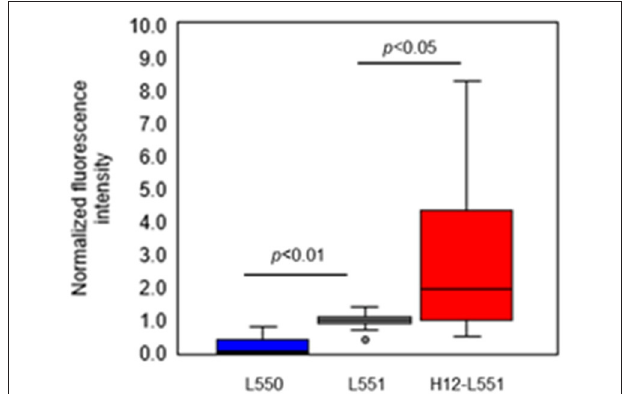
FIGURE 5 | Comparison of normalized fluorescence intensity of fluorescently labeled unmodified liposomes (L550, L551) and H12-modified liposomes (H12-L551) in platelet aggregates after optimizing the conditions (liposome concentration: 200 µ M, washing four times). The fluorescence intensity was normalized to mean fluorescence intensity of L551 in each experiment (7 independent experiments with three determinations). Whiskers indicate 0% and 100% quartiles; the boxes indicate 25% and 75% quartiles; the horizontal lines in the boxes indicate the 50% quartile; dot indicates outlier. Comparisons were made by a non-parametric Kruskal-Wallis one-way ANOVA followed by a Steel control test. See Figure S2 for the amount of